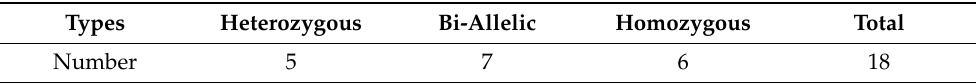
Table 2. Mutation types in T 0 generation.